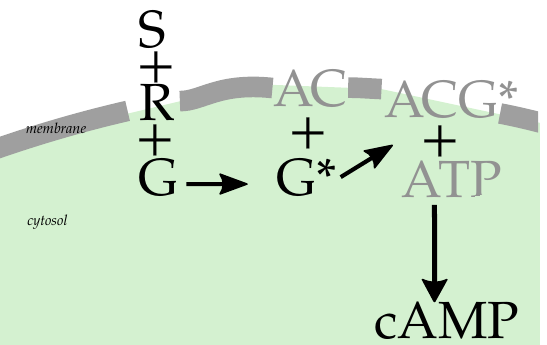
Figure 1. Simplified kinetic model illustrating how the second messenger molecule cAMP is produced downstream. The initial ternary reaction between the ligand (S), receptor (R) and G protein (G) on the cell membrane (gray line) leads to activated G protein (G ∗ ). This then is used together with membrane-bound AC and ATP from the cell cytosol (green) for cAMP production. We only depict the steps along the line of the conversion of the extra-cellular signal to production of the second messenger protein cAMP, which we explicitly model in this short